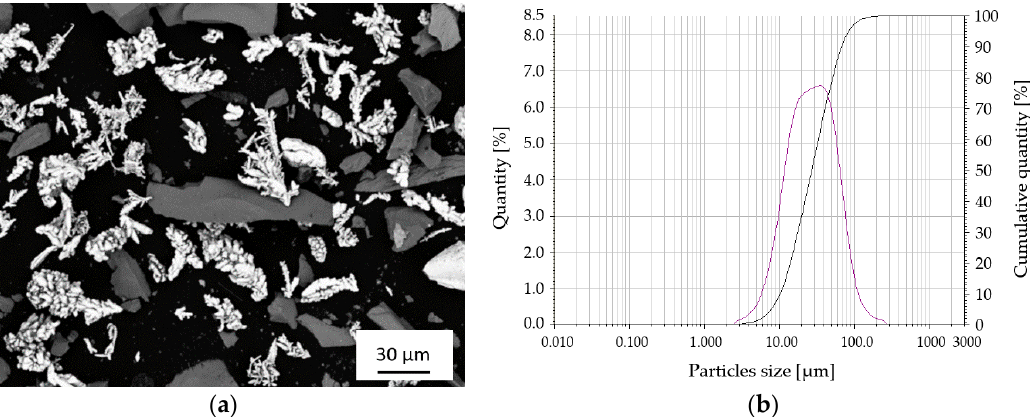
Figure 1. Scanning electron microscope—SEM (back-scattered electrons—BSE) micrograph of E-Cu/SiC powder (a mixture of dendritic Cu powder and SiC powder) ( a ) and size analysis of the mixed powders ( b ).